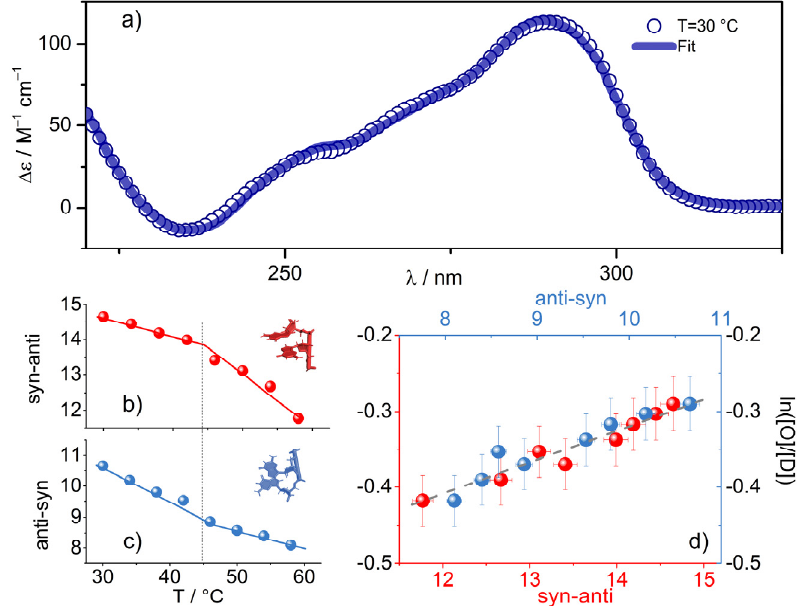
Figure 5. ( a ) Experimental CD profile for the Tel22 K+ water solution at 45 μ M and ambient temperature, shown together with the fitted curve (solid line) obtained by using the algorithm presented in Ref. [14]. ( b , c ) Percentages of syn–anti and anti–syn populations as a function of temperature (dotted line approximatively corresponds to T’ m1 ). ( d ) Correlation plot between syn–anti and anti–syn populations and the quantity ln([O]/[D]).